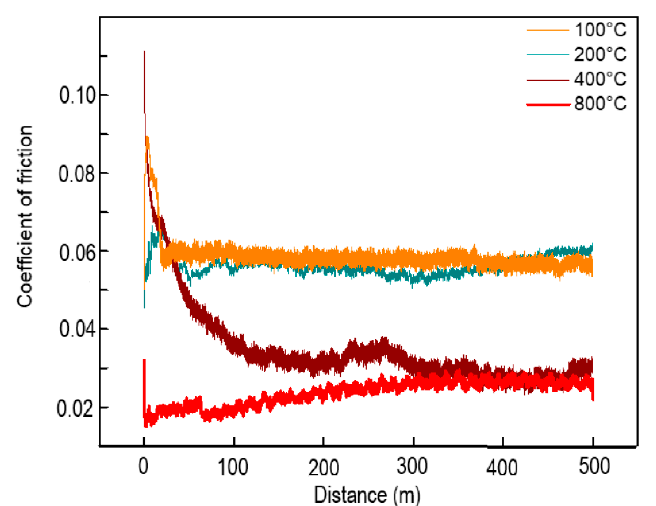
Figure 10. COF curves for HfCN coatings evaluated at temperatures of 100 °C, 200 °C, 400 °C and 800 °C.